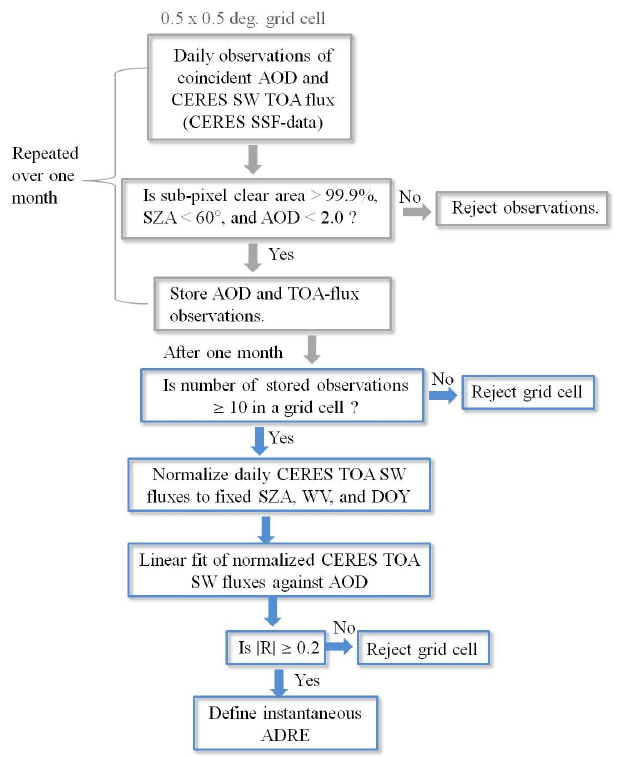
Figure 4. A schematic representation of the satellite-based method for deriving instantaneous SW ADRE at TOA using coincident CERES TOA flux and MODIS AOD observations.